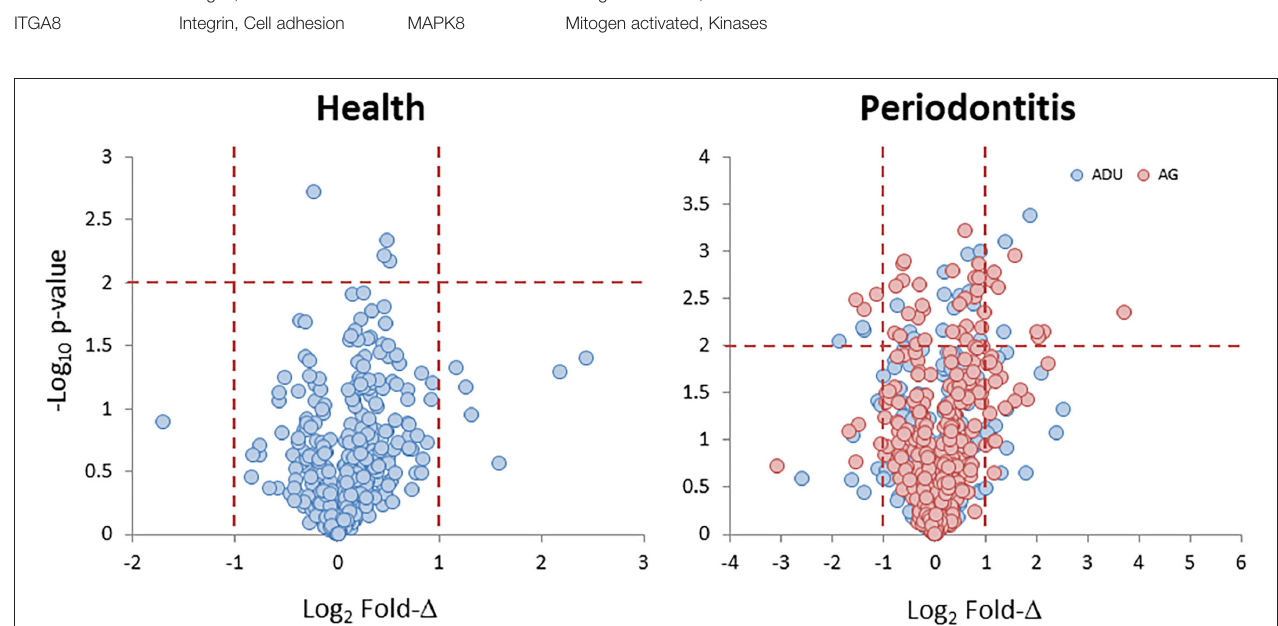
FIGURE 1 | Volcano plots of gene expression levels in aged animals compared to the healthy adult tissue levels (Health) and in samples from periodontitis in adult and aged animals compared to healthy adult levels (Periodontitis). Each point denotes one of the 425 annotated genes related to fold difference and statistical difference from adult levels. The red dashed lines signify a p < 0.01 and a 2-fold increase or decrease in